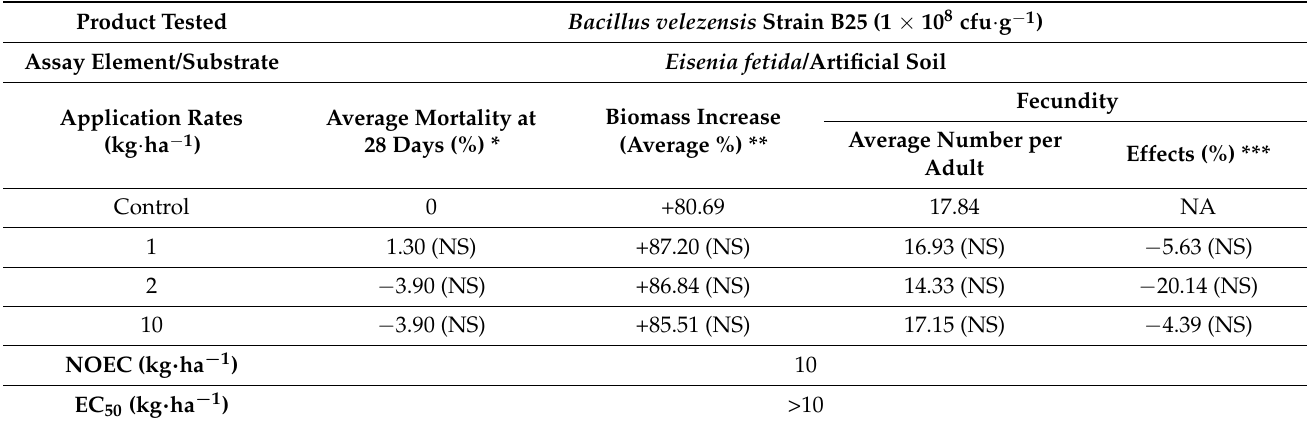
Table 8. Bacillus velezensis strain B25 effects on mortality, biomass increase, and fecundity of Eisenia fetida. NOEC stands for no observed effect concentration and EC50 for half maximal effective